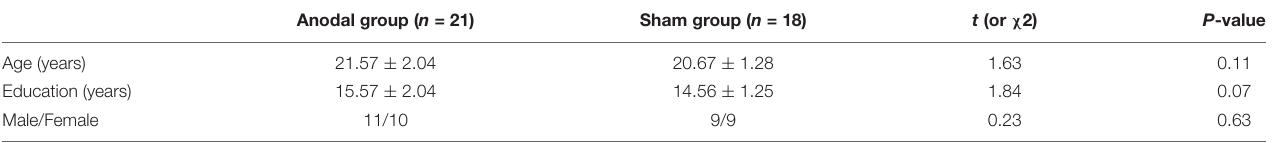
TABLE 1 | Demographic characteristics of participants.